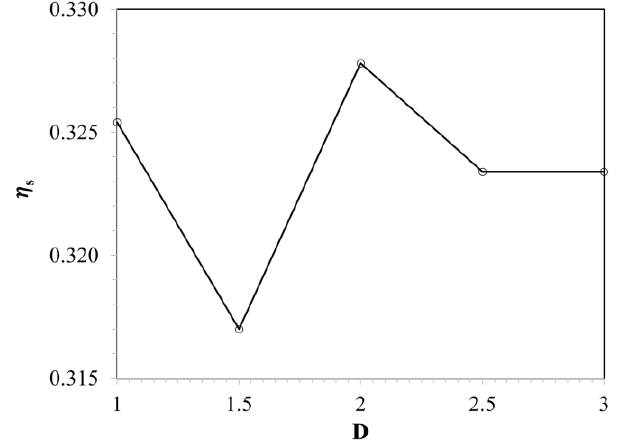
Figure 17. 𝜂 𝑠 with expansion in front of the exit hole. Figure 17. η s with expansion in front of the exit